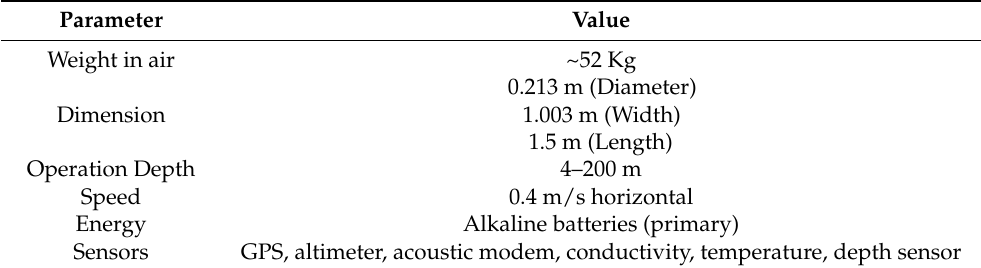
Table 1. Specifications of Slocum G1 glider